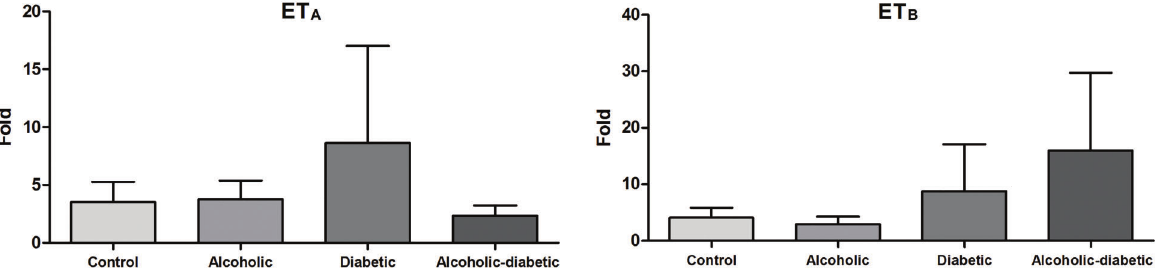
Figure 3. Mean ( ± standard error) of endothelin A (ET A ) and B (ET B ) expression in cavernous tissue samples of the groups studied. There were no signi fi cant differences among the groups (Kruskal-Wallis